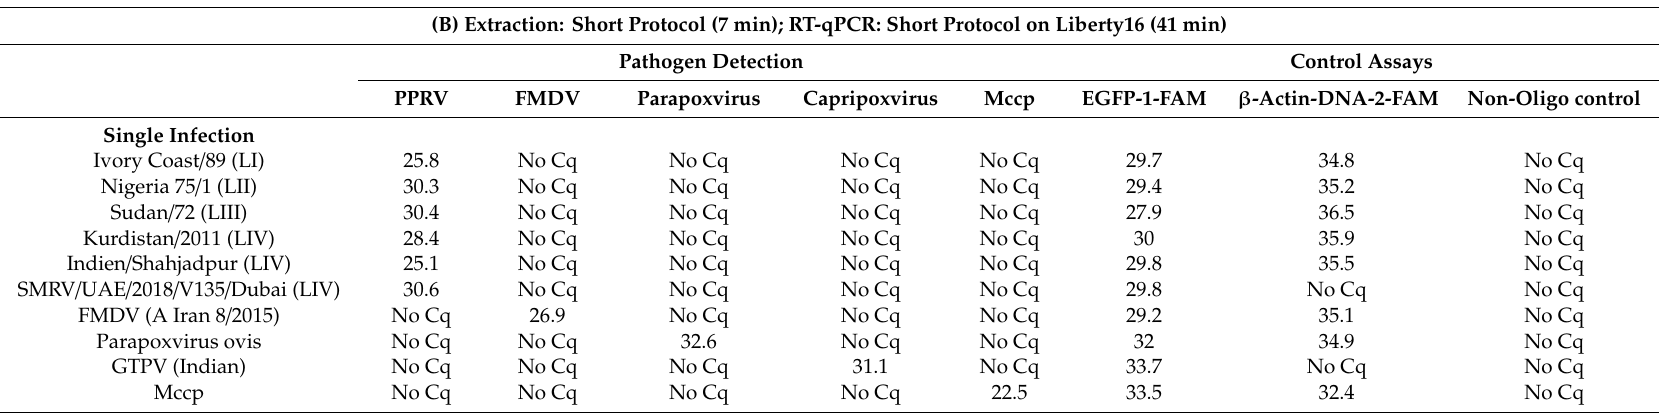
(B) Extraction: Short Protocol (7 min); RT-qPCR: Short Protocol on Liberty16 (41